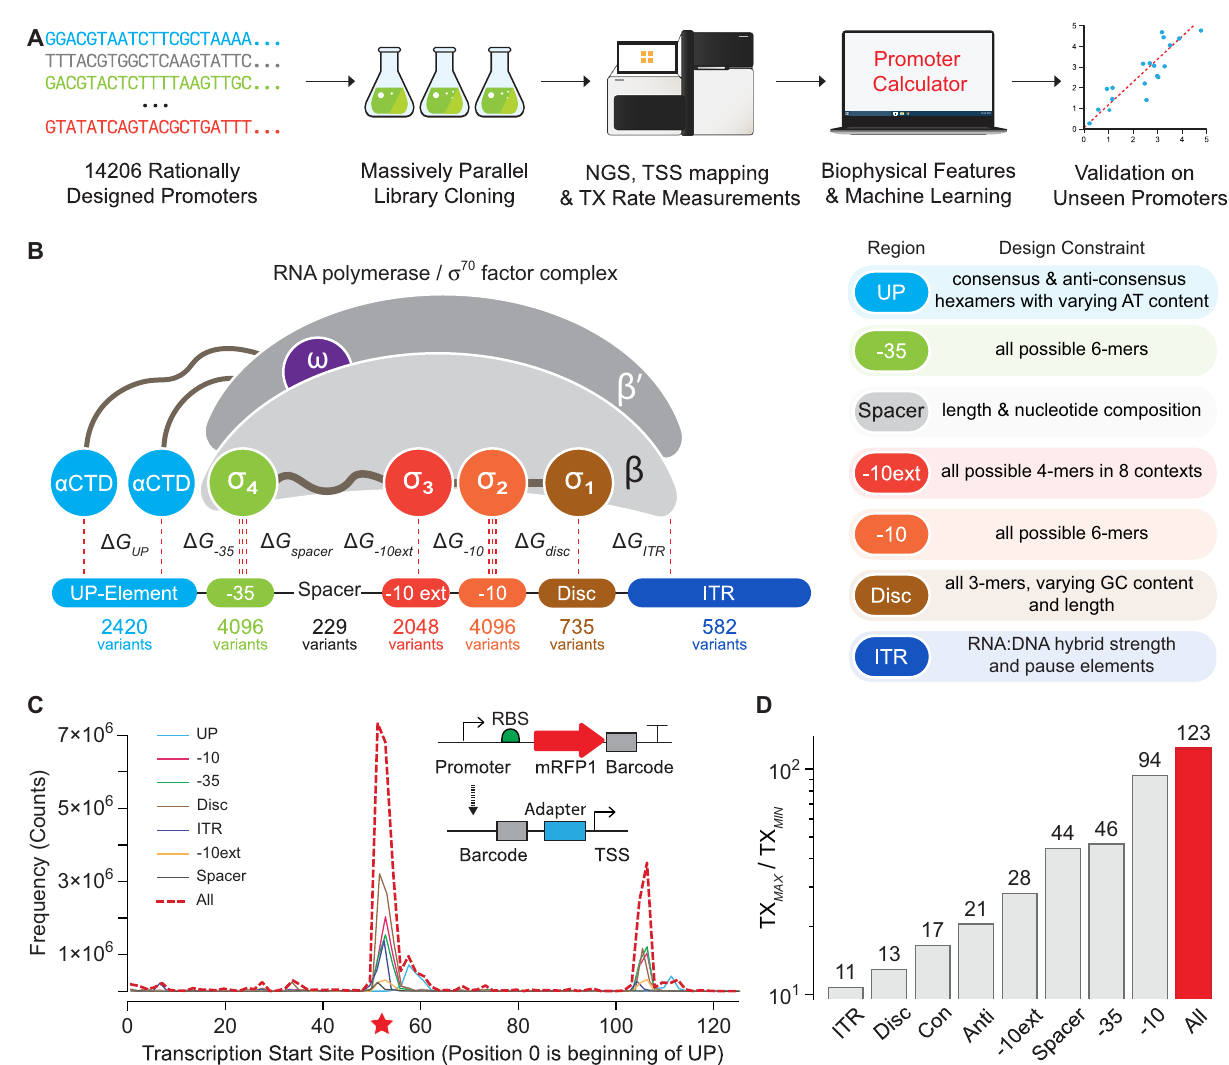
Fig. 1 | Massively Parallel Transcription Rate and Start Site Measurements. A Model development combined promoter design, barcoded oligopool synthesis, library cloning & culturing, and next-generation sequencing to measure the tran- scription start site distribution and transcription rate of each promoter variant. B The interaction strengths between RNAP/ σ 70 and promoter DNA control tran- scription initiation rates. 14206 promoter variants were designed to quantify how sequence modi fi cations affect each interaction. Sequence design criteria are shown. C The frequencies of observed transcription start sites are shown for each